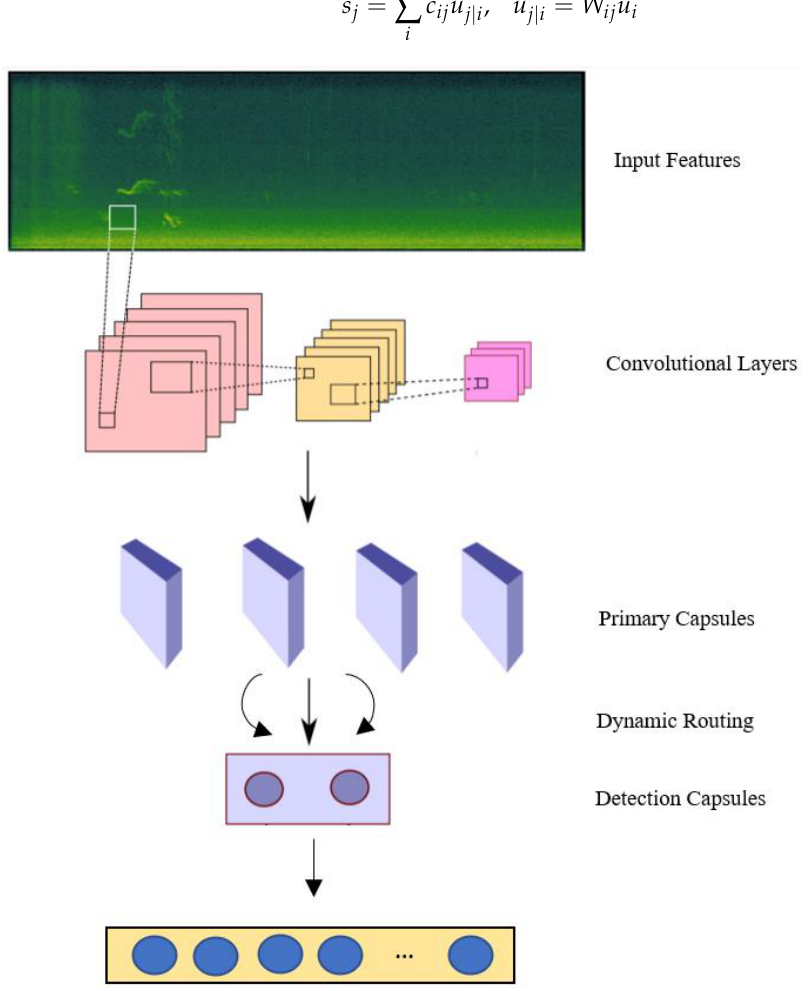
Figure 1. The architecture of the original CapsNet. [42]